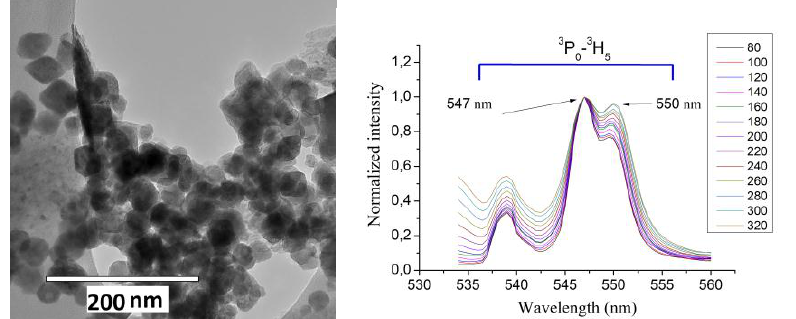
Fig. 1 . TEM data of Pr 3+ :LiYF 4 nanoparticles (a), normalized luminescence spectrum of Pr 3+ :LiYF 4 nanoparticles, corresponding to the arrival of 3 Р 0 - 3 Н 5 as a function of temperature (b)